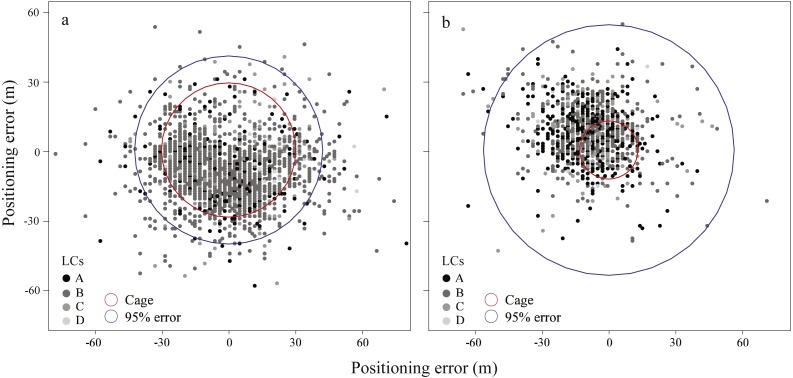
Map showing the location distribution relative to cage area and 95% positioning error bound at DZ (A) and TC (B).Locations were showed in graduated color for different Location Classes (LCs). Note that some extreme outliers were not showed in the map.